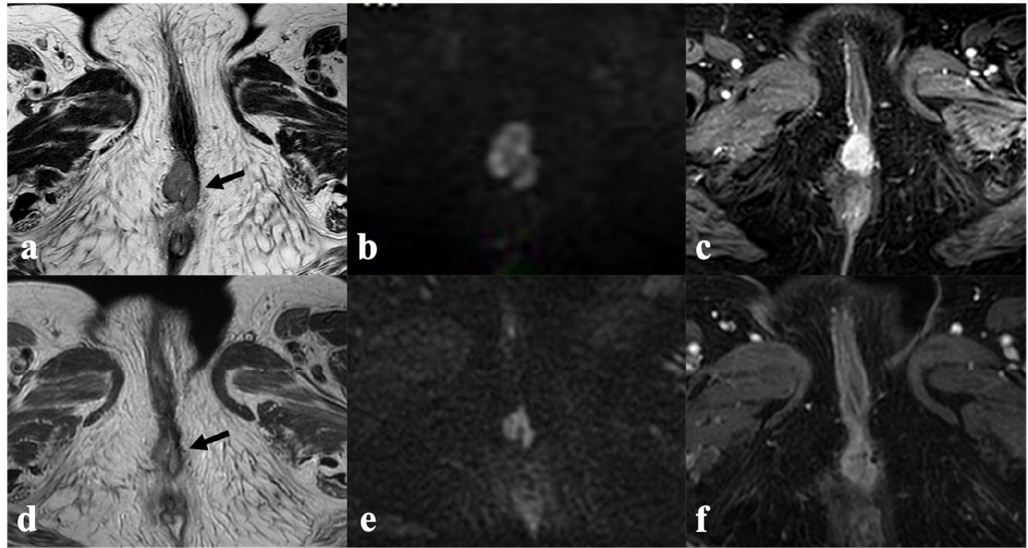
Figure 7. Complete response to CRT and brachytherapy in recurrent vulvar cancer. An 80-year-old patient with recurrent vulvar cancer after radical vulvectomy and lymphadenectomy, presenting with intermediate T2 solid tissue in left vulvar region (( a )—black arrow) with restricted diffusion in DWI and ADC map (( b , c )—white arrow). After CRT, brachytherapy was performed, with MRI monitoring after applicator insertion (( d – f )—white star key); axial ( d ) coronal ( e ) and sagittal ( f ) T2 images show that the applicator is correctly positioned, and no residual disease is visible. MRI at treatment completion shows tumor disappearance in both T2WI ( g ) and DWI/ADC map ( h , i ).